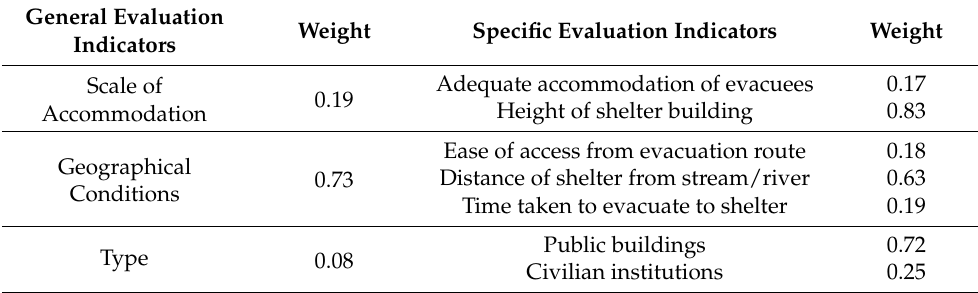
Table 6. Assignment of weights through the AHP method.